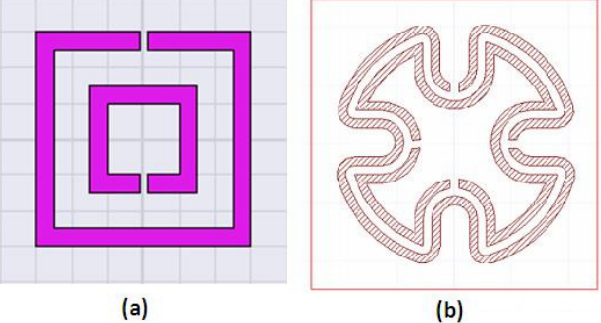
Figure 1: A unit cell geometry of (a) a rectangular SRR (b) a fan shaped SRR